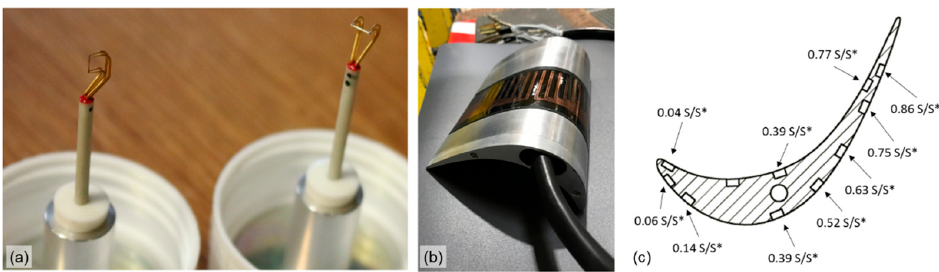
Figure 26. Selected devices for the acquisition of time-resolved measurement data: Dantec Dynamics type 55R56 and 55R57 SFP ( a ), assembly of modular T106 RUB blade with suction side hot-film instrumentation ( b ), arrangement of Kulite LQ-125 sensors along the profile ( c ).